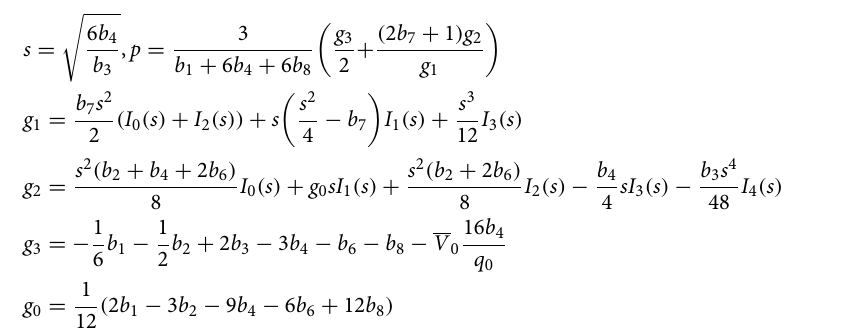
and I k ( k = 0,1,…,4) represent the k -order modified Bessel functions of the first kind. Discussions. In order to illustrate the current solution, a polyvinylidene difluoride (PVDF) axisymmetric circular plate is considered with its properties: E = 3.7 GPa, α = 1.38 × 10 10 N m 2 /C 2 , ε 0 = 8.854 × 10 −12 C 2 /(N m 2 ), f = − 179 N m/C, ρ = 1.78 × 10 3 kg/m 3 . The radius of the circular plate is set as 10 times the thickness and the length-scale parameters are assumed to be 1 μm. The dimensionless deflection is shown in Fig. 2 with the transverse load q being 1 μN/μm 2 and the electric voltage V 0 being 100 V. In Fig. 2, the static bending deflection of axisymmetric flexoelectric circular plate is small compared with its thickness, and the numerical results based on the linear and nonlinear models agree well with each other. This demonstrates that the accuracy of the linear model is sufficient for small deflection question. In addition, the numerical results agree well with the linear theoretical results. The DQM is suitable for solving the current problem. When the static bending deflection is comparable to the thickness of plate, the linear model does not work and we have to adopt the nonlinear model. The dimensionless nonlinear displacements are shown in Fig. 3 under different loads. Figure 3 shows the maximum deflection is about 30 ~ 60 times of that of maximum radial displacement. The radial displacement is small and can be neglected compared with its lateral deflection. From Fig. 3a, it can be found that the dimensionless deflection increases with the increase of transverse load q , while the dimensionless deflection decreases with the increase of electric voltage V 0 . This is because the transverse load q and the electric voltage V 0 generate an opposite bending deformation. The final result is a superposition of these two parts. In order to investigate the bending deflection induced by the inverse flexoelectric effect in detail, the dimensionless deflection of axisymmetric circular plate subjected to an electric voltage V 0 only between the upper and lower surfaces of the plate is shown in Fig. 4. The bending deflection induced by the inverse flexo- electric effect is small and opposite in comparison with that generated by transverse load q . Furthermore, the inverse flexoelectric effect strengthens as the thickness of plate decreases, which can be further enhanced as the thickness of flexoelectric circular plate reaches nanometer scale. Figure 5 reveals the influence of strain gradient stiffening effect on the dimensionless bending deflection in the inverse flexoelectric process. When the plate thickness is comparable with the material length scale parameter, the dimensionless deflection with l 0 = l 1 = l 2 ≠ 0 (including all strain gradient stiffening effect) is far smaller than that with l 0 = l 1 = l 2 = 0 (ignoring all the strain gradient stiffening effect). This demonstrates the stiffening effect of strain gradient is remarkable. When the plate thickness is far great than the material length scale parameter, the dimensionless deflection with l 0 = l 1 = l 2 ≠ 0 is close to that with l 0 = l 1 = l 2 = 0. This demonstrates that the stiffening effect of strain gradient is negligible in comparison with the traditional plate bending rigidity. Moreover, the stiffening effects of the strain gradient spherical component ( l 0 ≠ 0), the deviatoric stretch gradient component